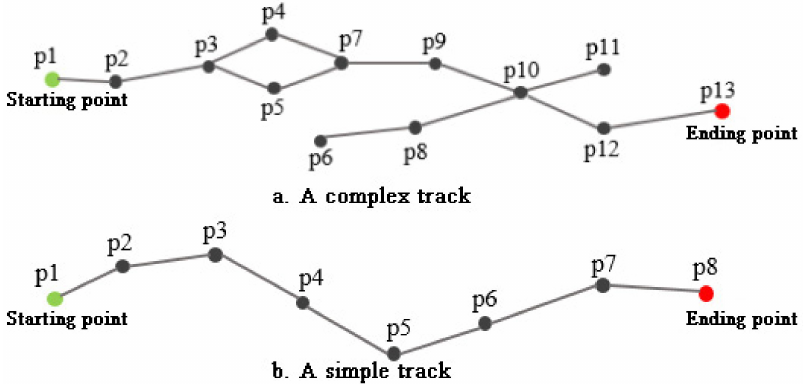
Figure 1. A complex trajectory ( a ) and a simple trajectory ( b